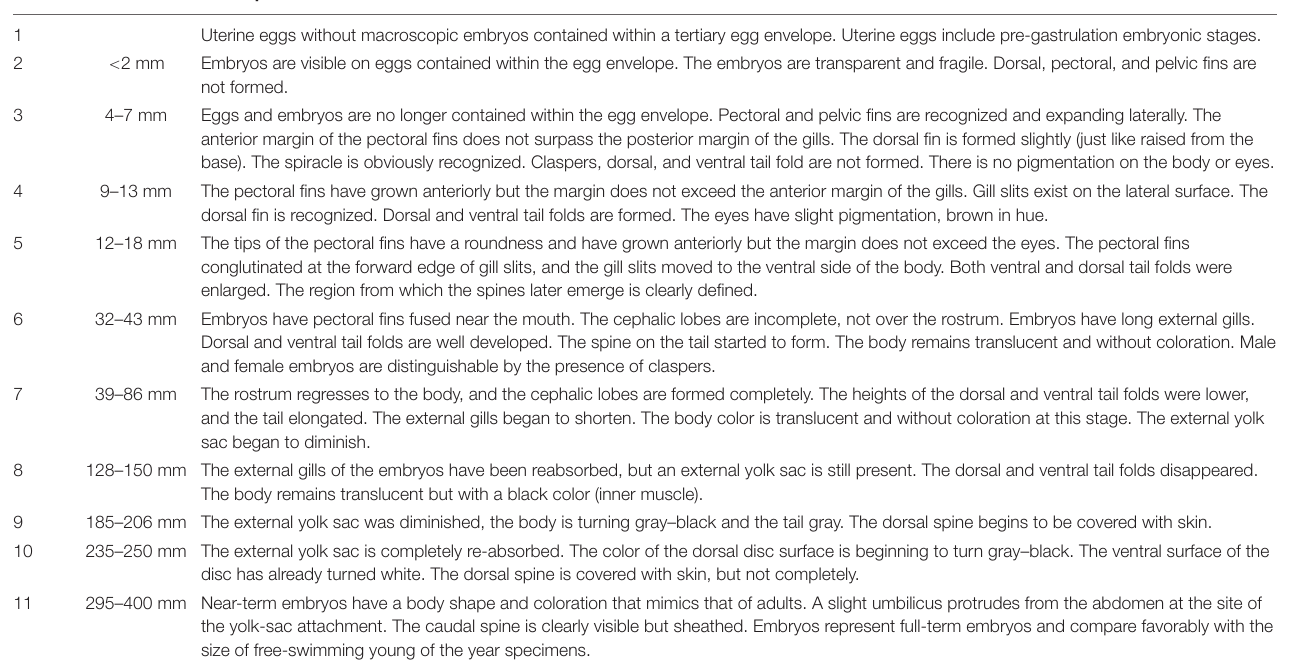
TABLE 1 | Developmental cohorts for Aetobatus narutobiei